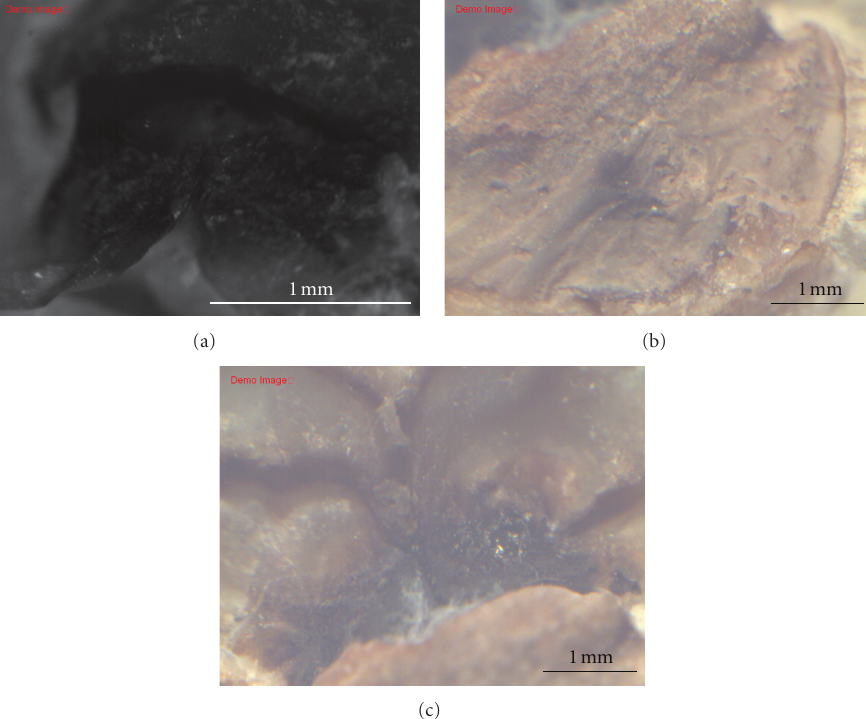
Figure 4: Stereomicroscope images of decayed tooth surface (a) before and (b, c) after acousto-optic Q-switched Nd:YAG quasicontinuous laser